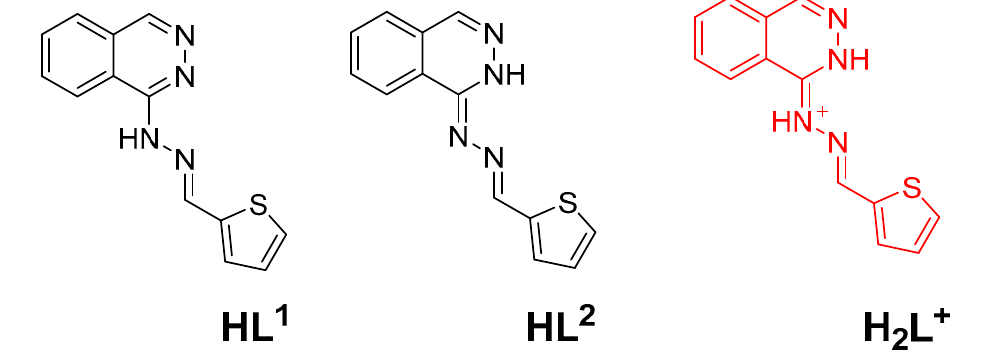
Figure 2. The possible tautomers of the ligand HL and its protonated form.